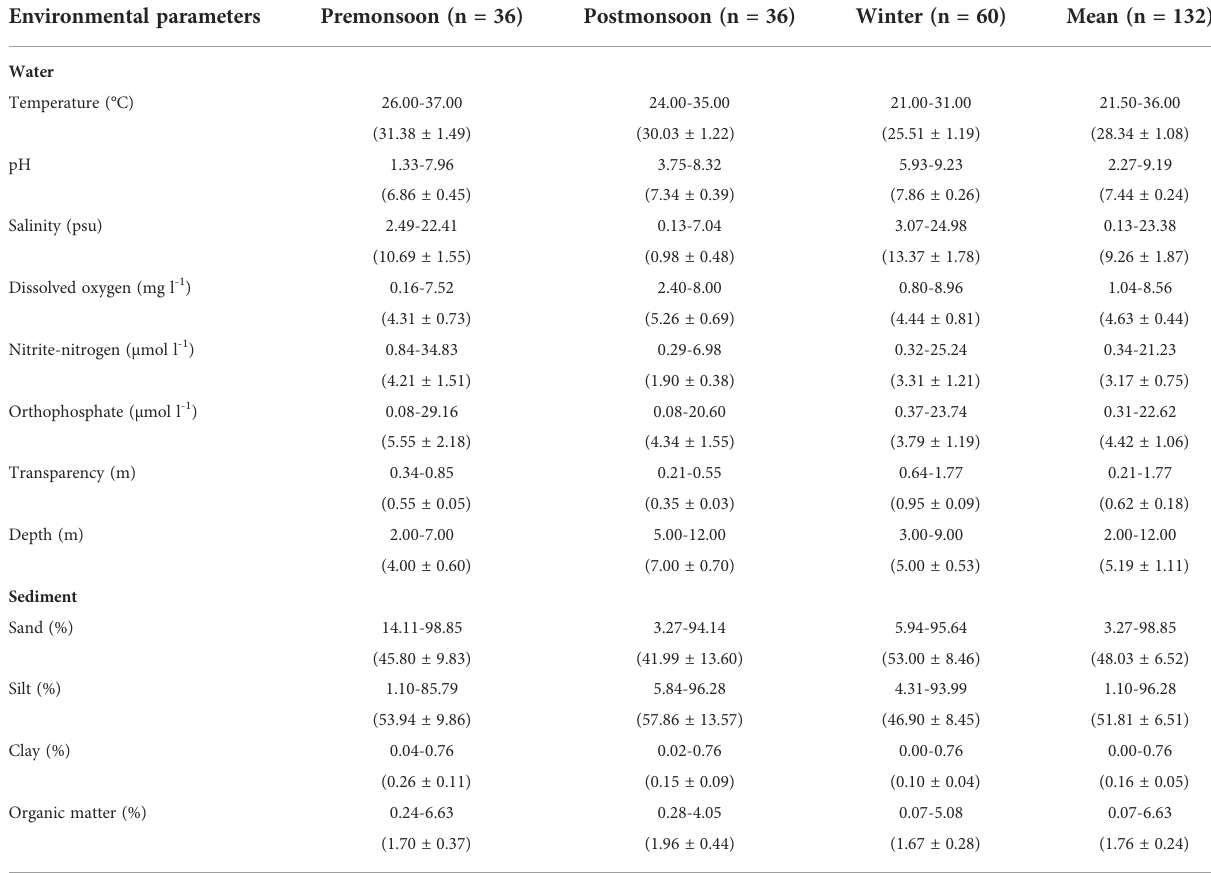
TABLE 1 Hydrographical and sediment characteristics of Mahanadi estuary during February 2013-March 2017. Environmental